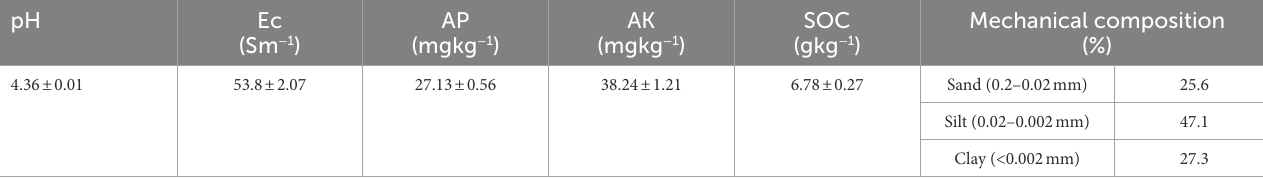
TABLE 1 Basic physical and chemical properties of the test soil. pH